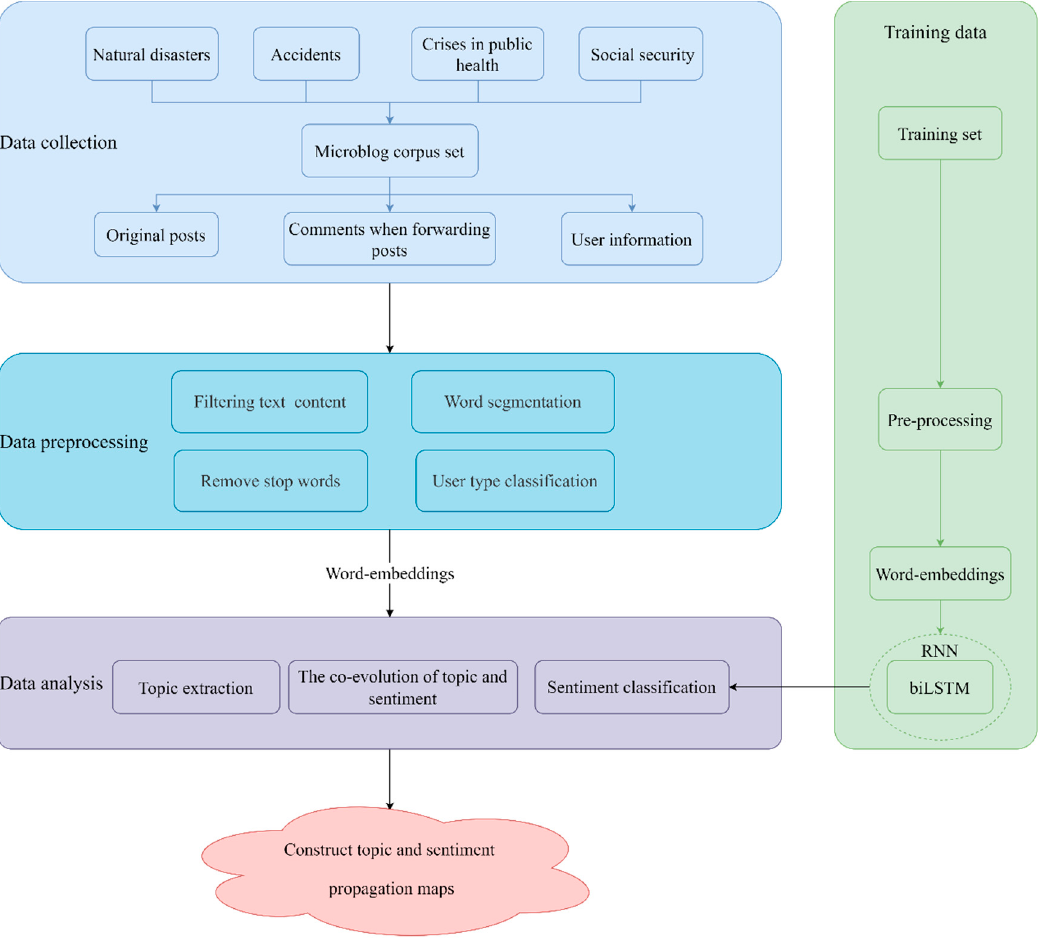
Figure 3. Research framework.